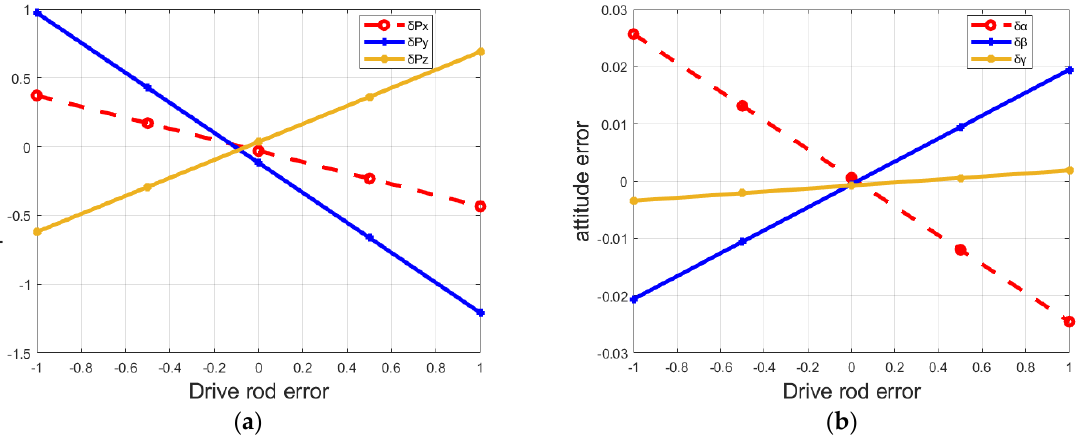
Figure 5. Influence of drive rod 2 error on FRR end-effector pose error: ( a ) drive rod 2 error on positional error; ( b ) drive rod 2 error on attitude error.